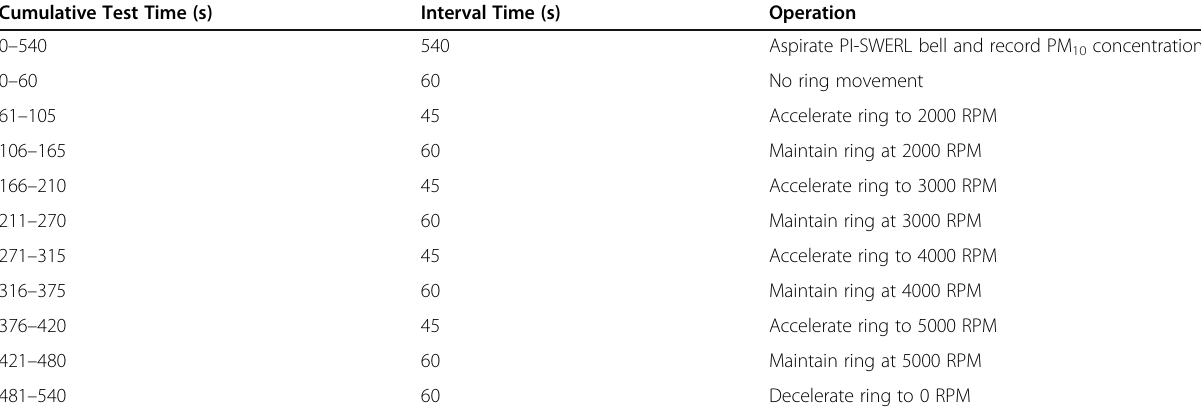
Table 1 Summary of the hybrid PI-SWERL test used to assess surface dust emissivities and threshold friction velocities Cumulative Test Time (s) Interval Time